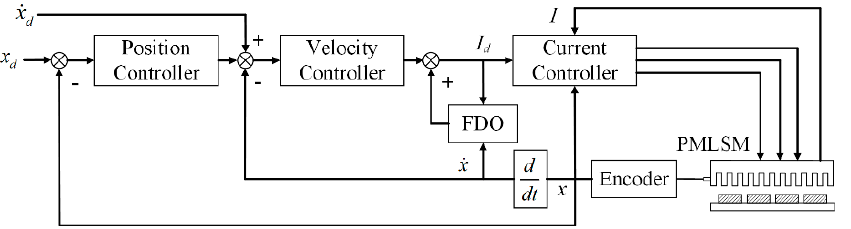
Figure 24. The control block diagram of a force disturbance observer (DOB). Reprinted with permission from ref. [7]. Copyright 2010 MDPI.